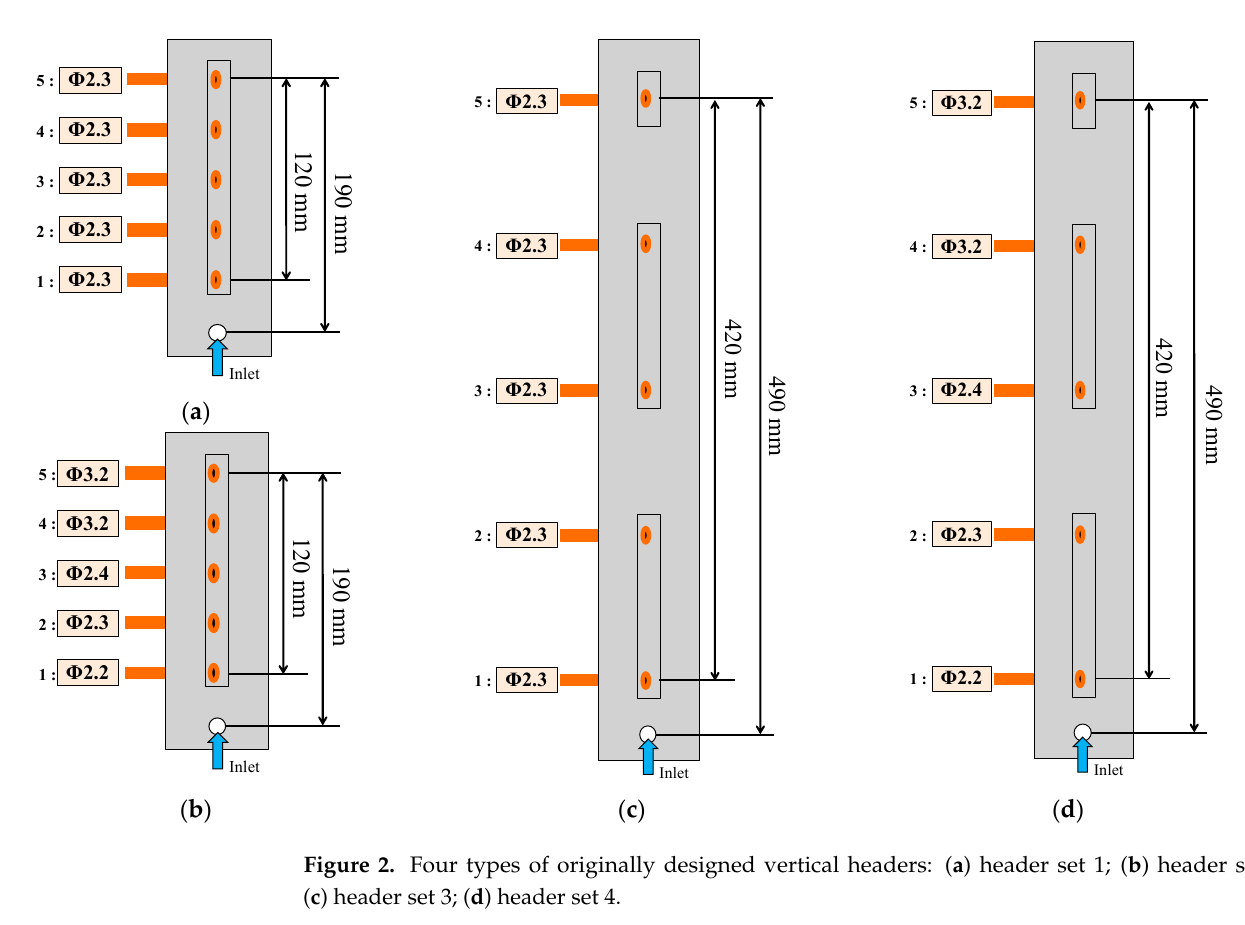
Figure 2. Four types of originally designed vertical headers: ( a ) header set 1; ( b ) header set 2; ( c ) header set 3; ( d ) header set 4. Table 2. Details of the four header